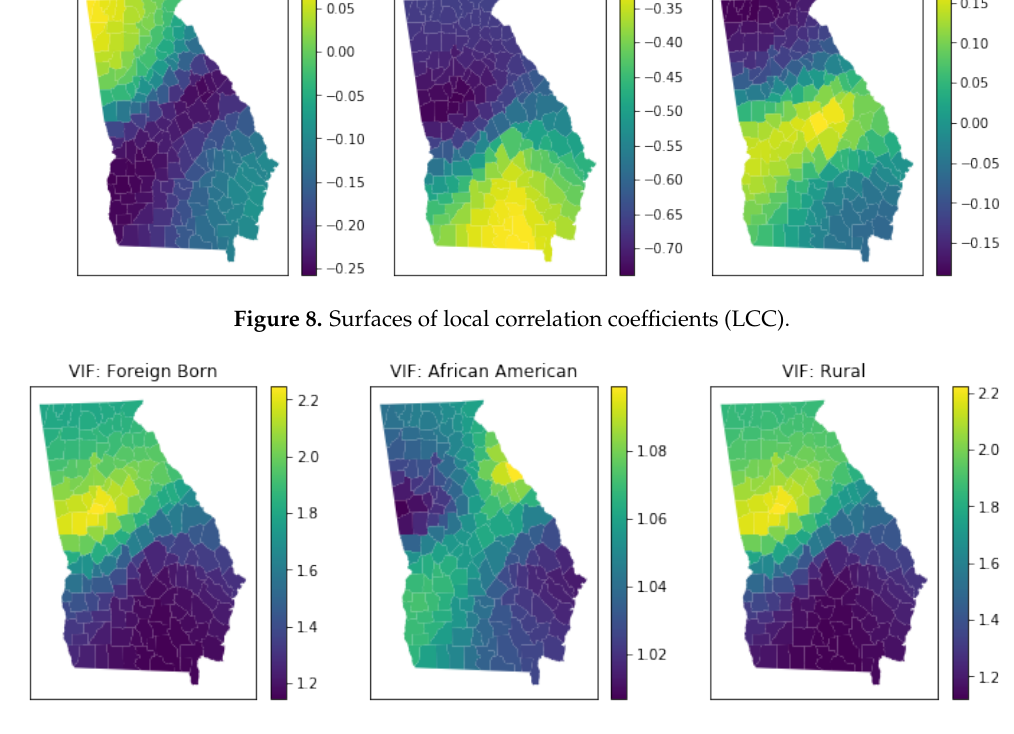
Figure 9. Surfaces of local variation inflation factors (VIF).